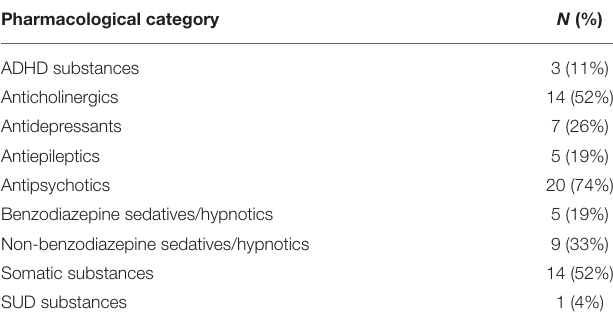
TABLE 1 | Overview of pharmacological treatment in the MDO group ( N =